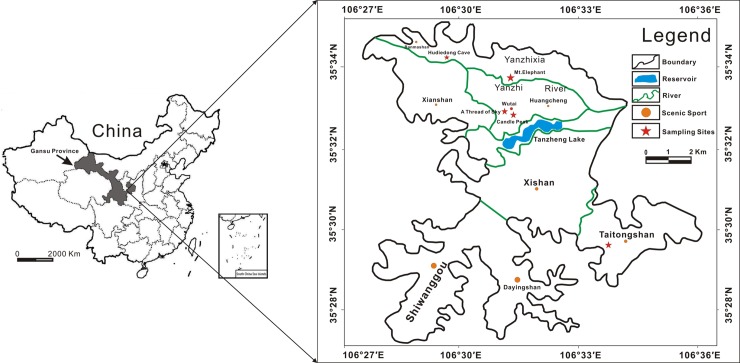
Location of Kongtongshan National Geopark in China.